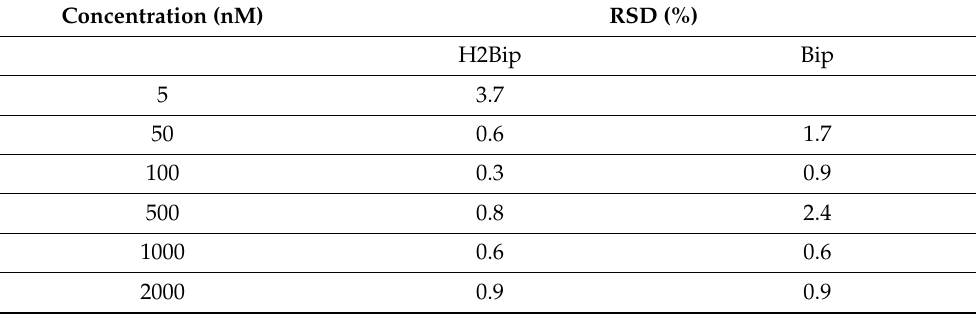
Table 2. Precision of the method ( n = 3) for 7,8-H2Biopterin (H2Bip) and biopterin (Bip) quantification.